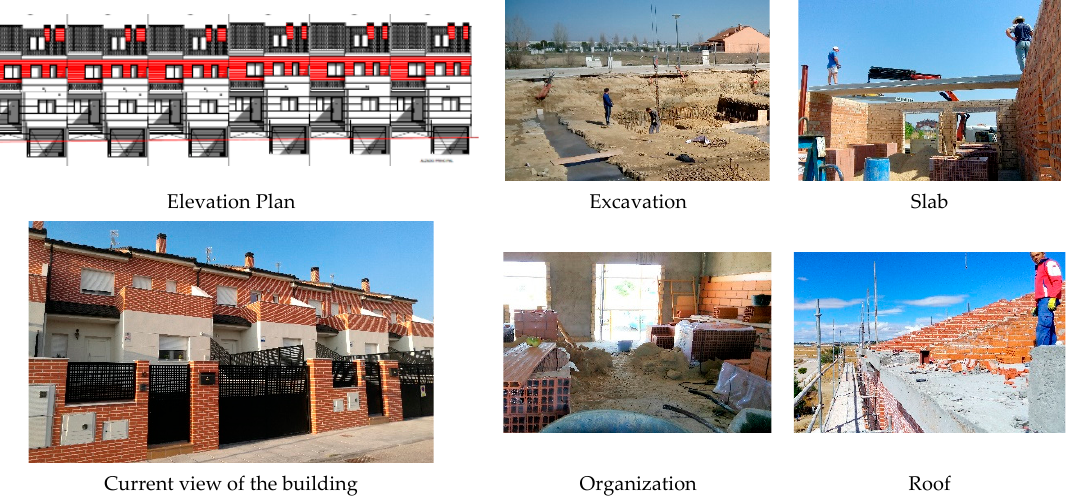
Figure 1. Elevation plan. Current view. Risk situations on site.